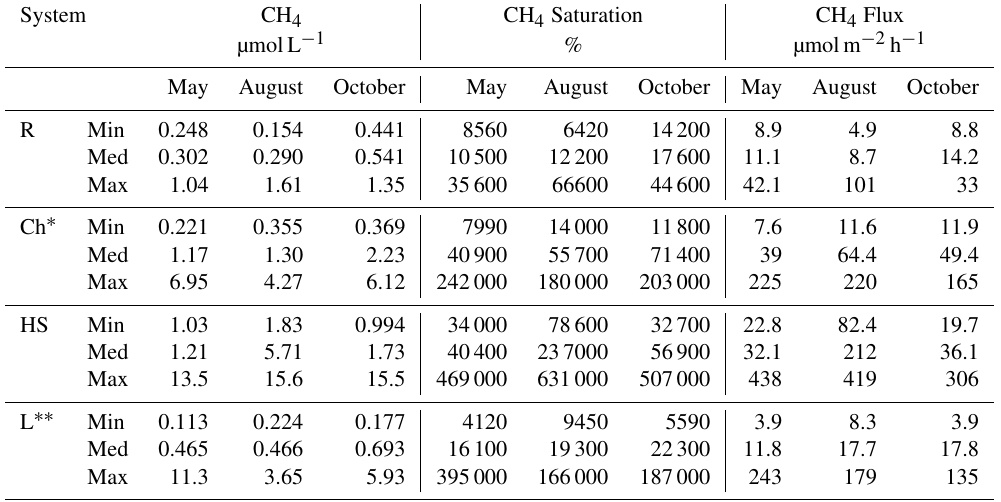
Table 1. Range (minimum: Min, maximum: Max) and median (Med) of CH 4 concentrations (µmolL − 1 ), CH 4 saturation (%) and CH 4 flux (µmolm − 2 h − 1 ) for rivers (R), channels (Ch) the hot spot channel (HS) and lakes (L) over the three seasons: May, August and October 2017.